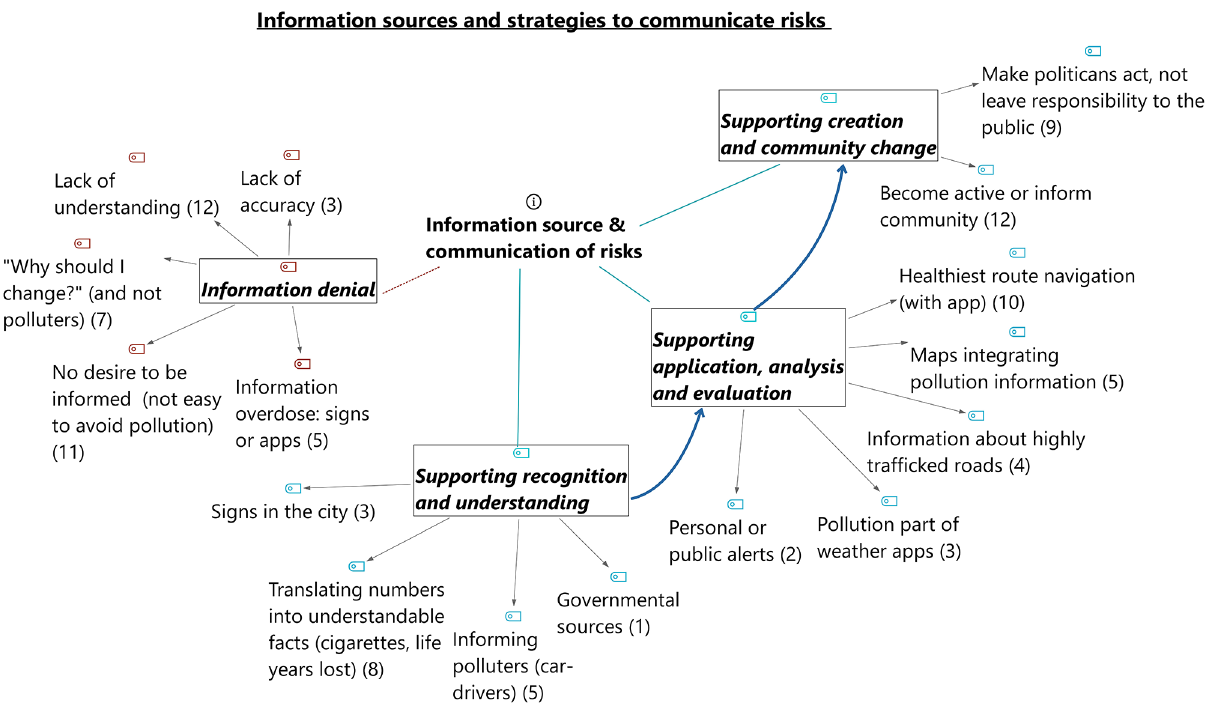
Fig. 1 Overview of the codes retrieved during the thematic coding. The main codes are based on the main steps of increasing Environmental Health Literacy (blue), which built on one another. It starts with recognition and understanding, then leads to application, analysis and evaluation and ultimately results in creation and community change. The retrieved codes were allocated to the suitable EHL stage. Statements regarding information denial were coded separately